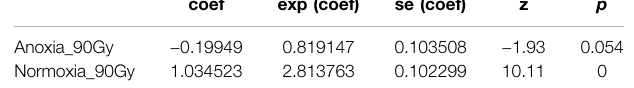
TABLE 7 | Fixed coef fi cients of the effects of anoxia with high doses on longevity for males only. coef exp (coef) se (coef)